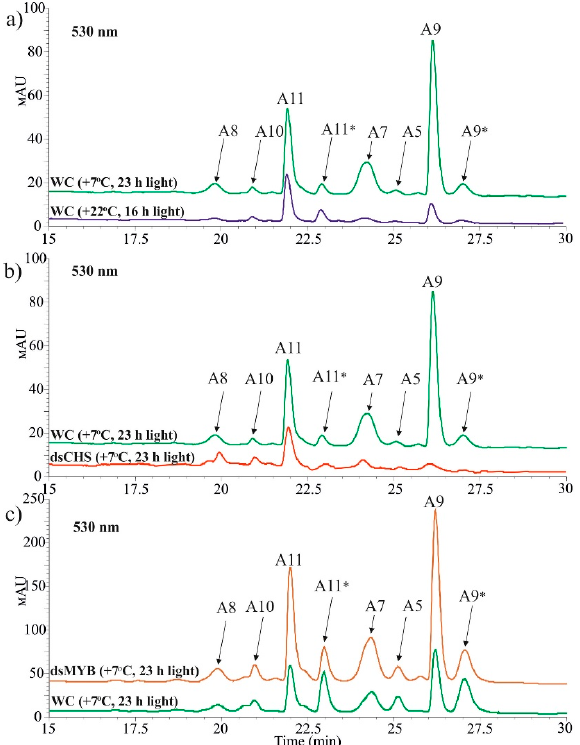
Figure 4. HPLC chromatograms of anthocyanins in Arabidopsis thaliana treated with water, AtCHS - dsRNA, or AtMybL2 -dsRNA (detected at 530 nm). ( a ) Induction of anthocyanin production in water- treated plants (WC) under anthocyanin-induction conditions (+7 °C, 23 h light) in comparison with the control (+22 °C, 16 h light); ( b ) The effect of AtCHS -dsRNA treatment on anthocyanin profiles in A. thaliana ; ( c ) The effect of AtMybL2 -dsRNA treatment on anthocyanin profiles in A. thaliana . A8—Cyanidin 3- O -[2 ′′ - O -(xylosyl) 6 ′′ - O -( p -O-(glucosyl) p-coumaroyl) glucoside] 5- O -[6 ′′′ - O -(malonyl) glucoside]. A10—Cyanidin 3- O -[2 ′′ - O -(2 ′′′ - O -(sinapoyl) xylosyl) 6 ′′ - O -( p - O -(glucosyl) p -coumaroyl) glucoside] 5- O -glucoside. A11. Cyanidin 3- O -[2 ′′ - O -(6 ′′′ - O -(sinapoyl) xylosyl) 6 ′′ - O -( p - O -(glucosyl)- p-coumaroyl) glucoside] 5- O -(6 ′′′′ - O -malonyl) glucoside. A7—Cyanidin 3- O -[2 ′′ - O -(2 ′′′ - O -(sinapoyl) xylosyl) 6 ′′ - O -( p -coumaroyl) glucoside] 5- O -glucoside. A5—Cyanidin 3- O -[2 ′′ - O -(xylosyl)-6 ′′ - O -(p- coumaroyl) glucoside] 5- O -malonylglucoside. A9—Cyanidin 3- O -[2 ′′ - O -(2 ′′′ - O -(sinapoyl) xylosyl) 6 ′′ - O -( p - O -coumaroyl) glucoside] 5- O -[6 ′′′′ - O -(malonyl) glucoside]. * — Asterisk indicates a tauto-